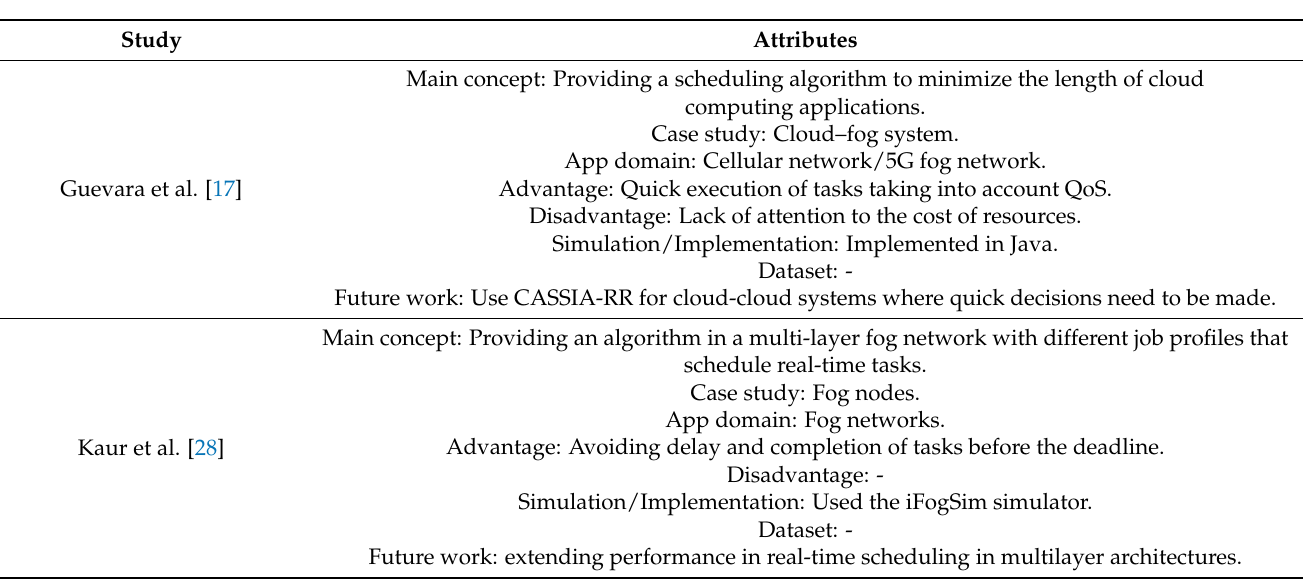
Table 2. Categorizing the state-of-the-art in urban computing applications.